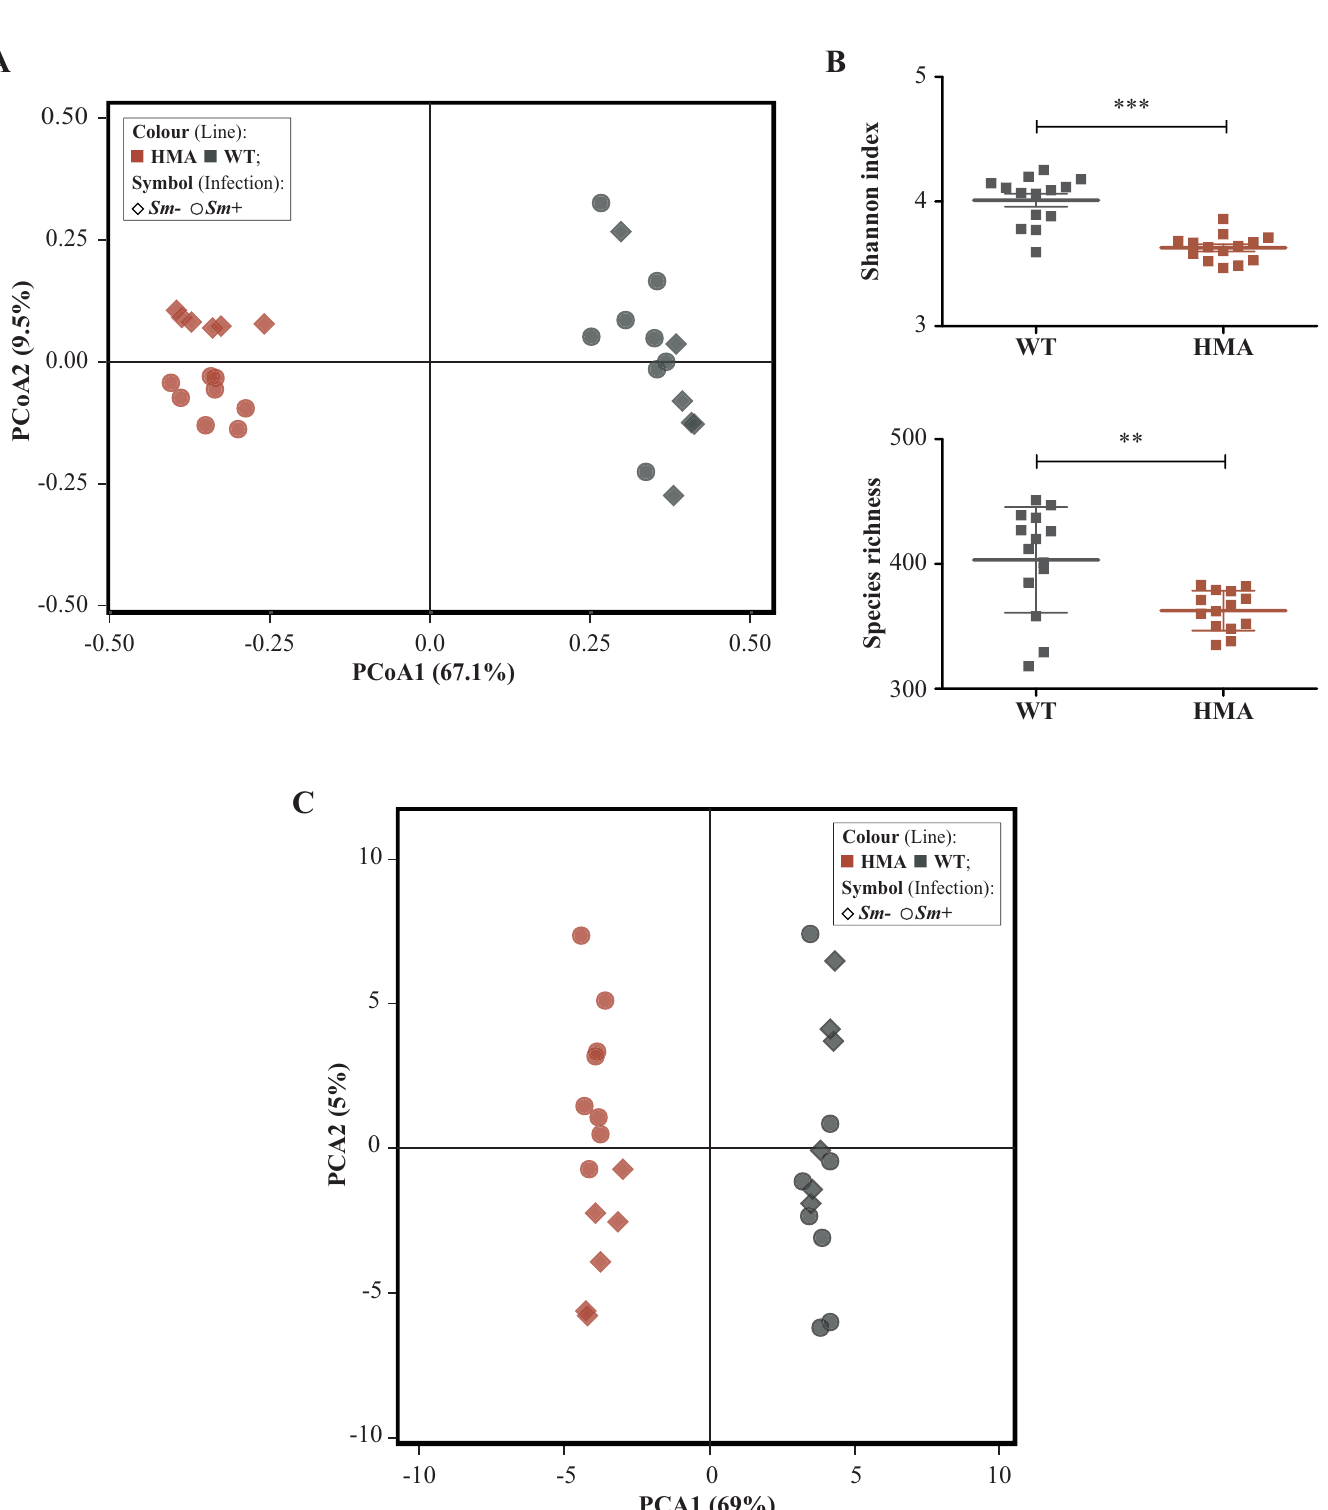
Fig 2. Compositional and functional profiles of the gut metagenomes of wild type (WT) and human-microbiota-associated (HMA) mice. (A) Principal Coordinates Analysis (PCoA) of microbial community composition of all Schistosoma -infected and -uninfected animals in both experiments, determined by mapping of shotgun metagenomic reads against bacterial reference genomes available from the GenBank database. (B) Alpha diversity. (C) Principal Component Analysis (PCA) of pathway relative abundances at community-level as determined by HUMAnN3. Asterisks indicate significant differences between groups determined by unpaired t-test: �� p < 0.01; ��� p <